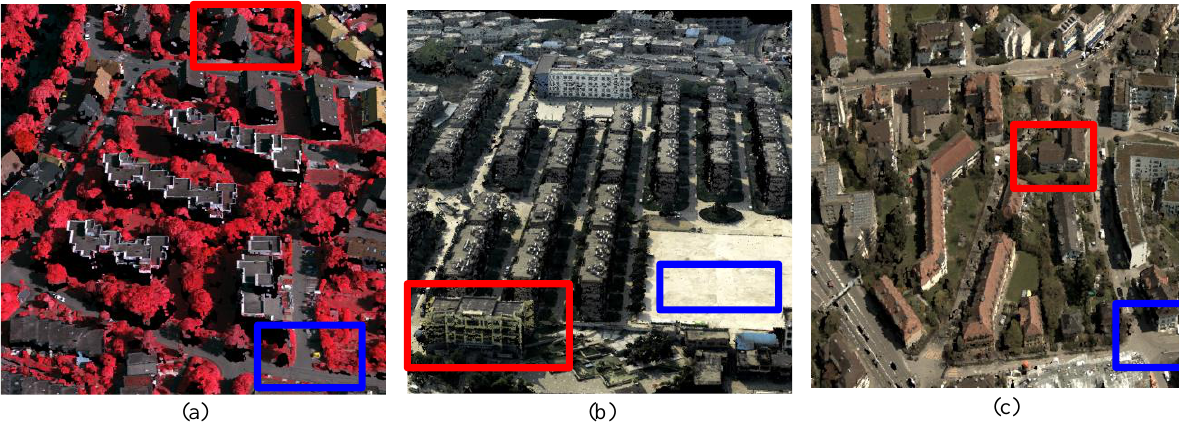
Figure 4. Comparison of different texture representations. From left to right: original images, derivatives implemented by the original SGM (Hirschmuller, 2008), canny edges implemented in SURE (Rothermel et al., 2012), and the proposed texture representation. Top row: comparison in a cement square; Bottom row: residential building roof with small structures.